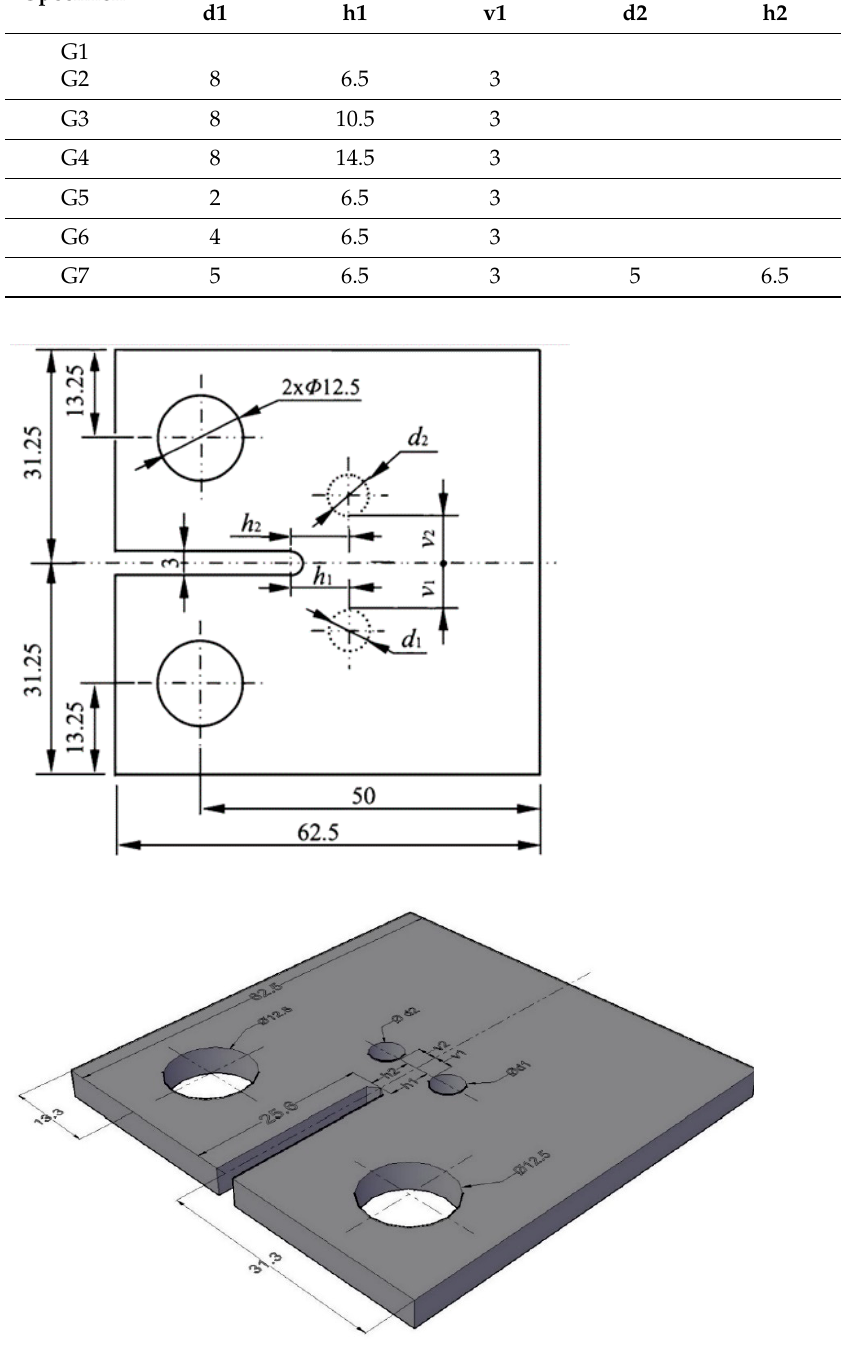
Table 1. Geometrical parameters for MCTS.